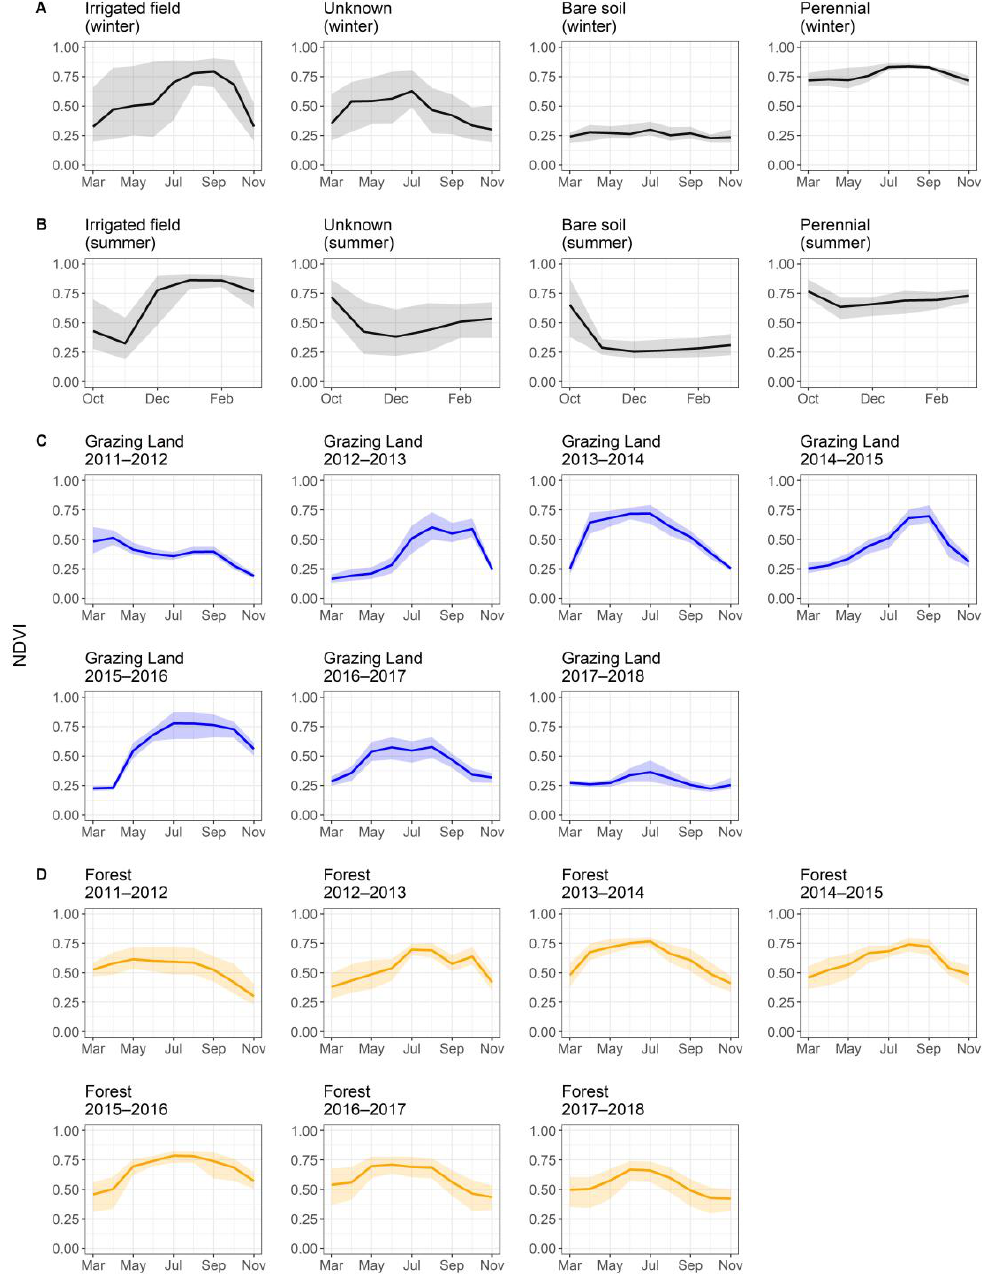
Figure 6. ( A ) Examples of static fields in winter; ( B ) examples of static fields in summer; ( C ) nonirrigated grazing land samples collected via Google Earth; and ( D ) forest samples collected via Google Earth. Images for nonirrigated grazing land and forests from Google Earth are displayed in Section S3 of the Supplementary Materials (Figure S3).